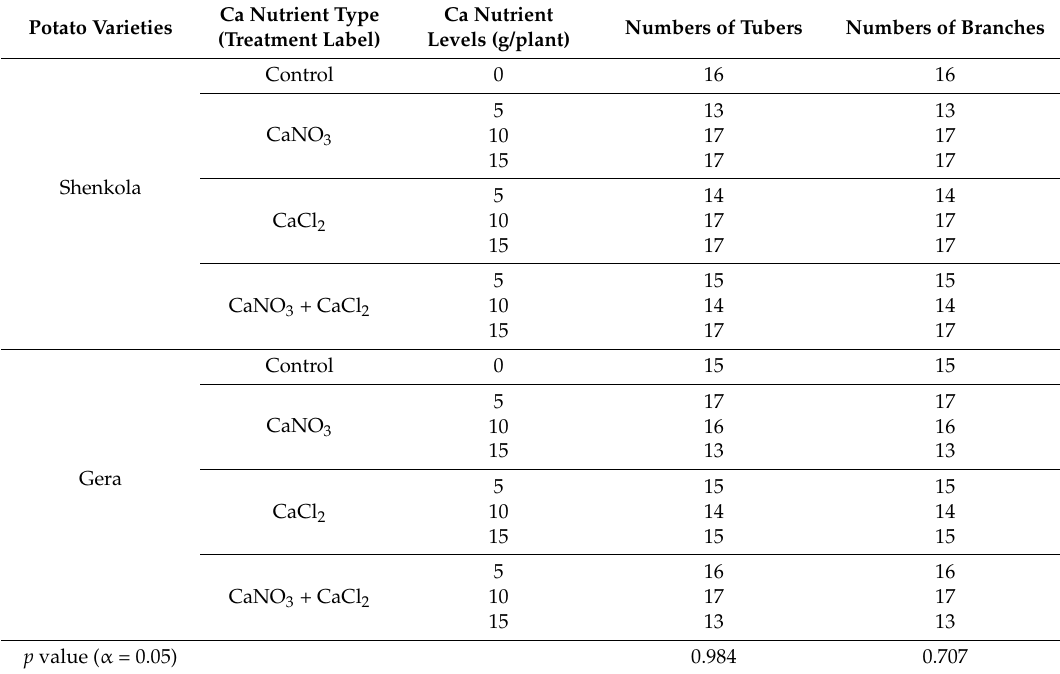
Table 1. Number of tubers and number of branches of two potato varieties (Shenkola and Gera) supplied with CaNO 3 alone, CaCl 2 alone, and CaNO 3 mixed with CaCl 2 (1:1), as well as their respective control plants.